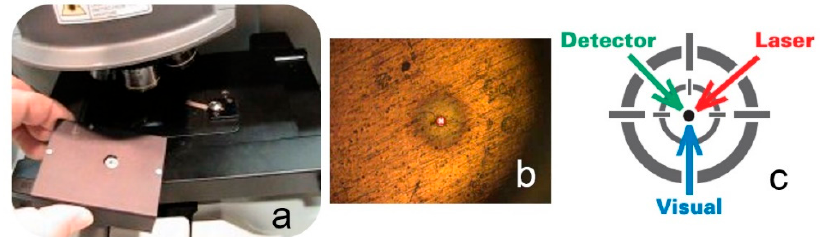
Figure 2. The alignment and calibration tool: ( a ) The tool to be placed on the microscope stage; ( b ) The bright pinhole in the optical focus centered in the binocular cross-hair; ( c ) A schematic diagram showing the optimal alignment of the sampling point, laser excitation, and visual spot.